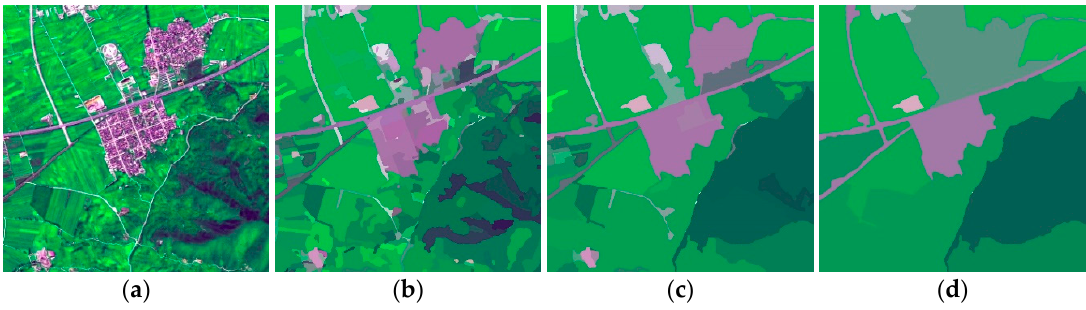
Figure 8. gPb -owt-ucm segmentation at different thresholds, with regions represented by their mean colors. ( a ) Original image; ( b ) threshold = 0.2; ( c ) threshold = 0.5; ( d ) threshold = 0.8.